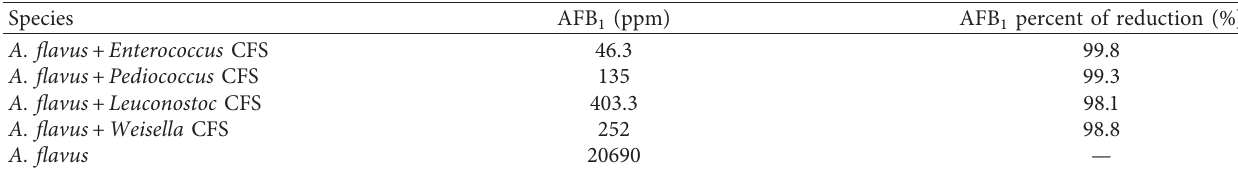
1 produced by toxigenic A. flavus